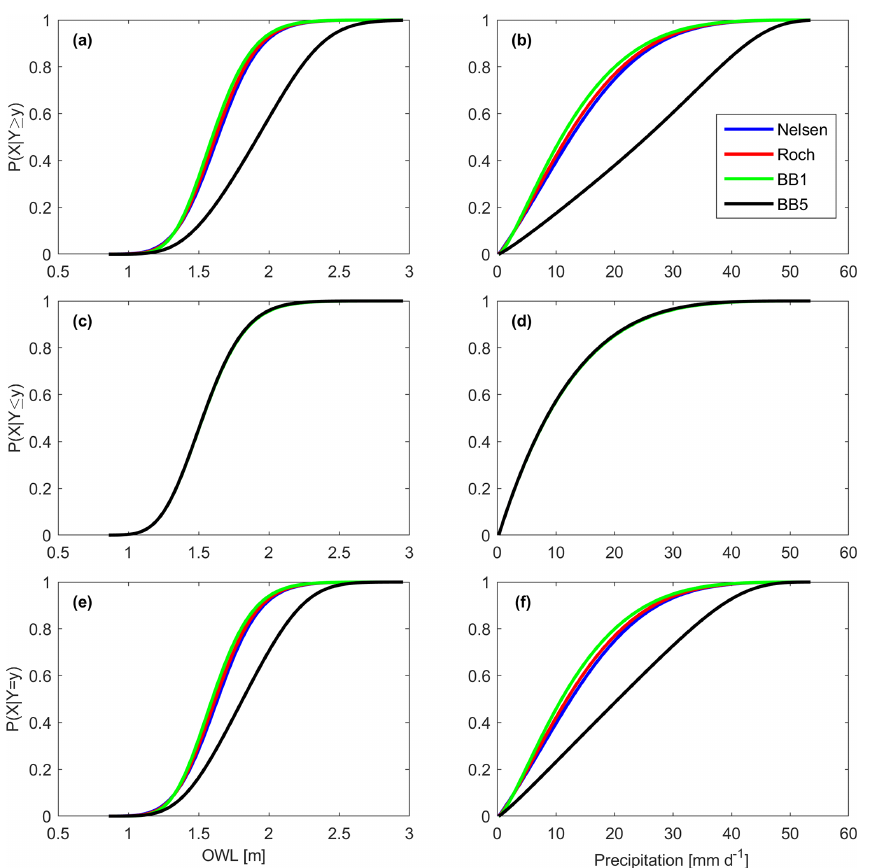
Figure 4. San Diego wet-season monthly coinciding OWL (left column) and precipitation (right column) (a, b) C1, (c, d) C2, and (e, f) C3 CDFs using the Nelsen (blue), Roch–Alegre (Roch), BB1 (green), and BB5 (black) copulas. OWL and precipitation conditionals are conditioned on the occurrence of a 25-year precipitation or OWL event. Table 5. San Diego 10-year marginal (M), conditional (C), and bivariate OWL (m) and precipitation (mmd − 1 ) values using wet-season monthly coinciding sampling. Conditionals are conditioned on a 25-year event occurrence. Nelsen Roch. BB1 BB5 OWL Precipitation OWL Precipitation OWL Precipitation OWL